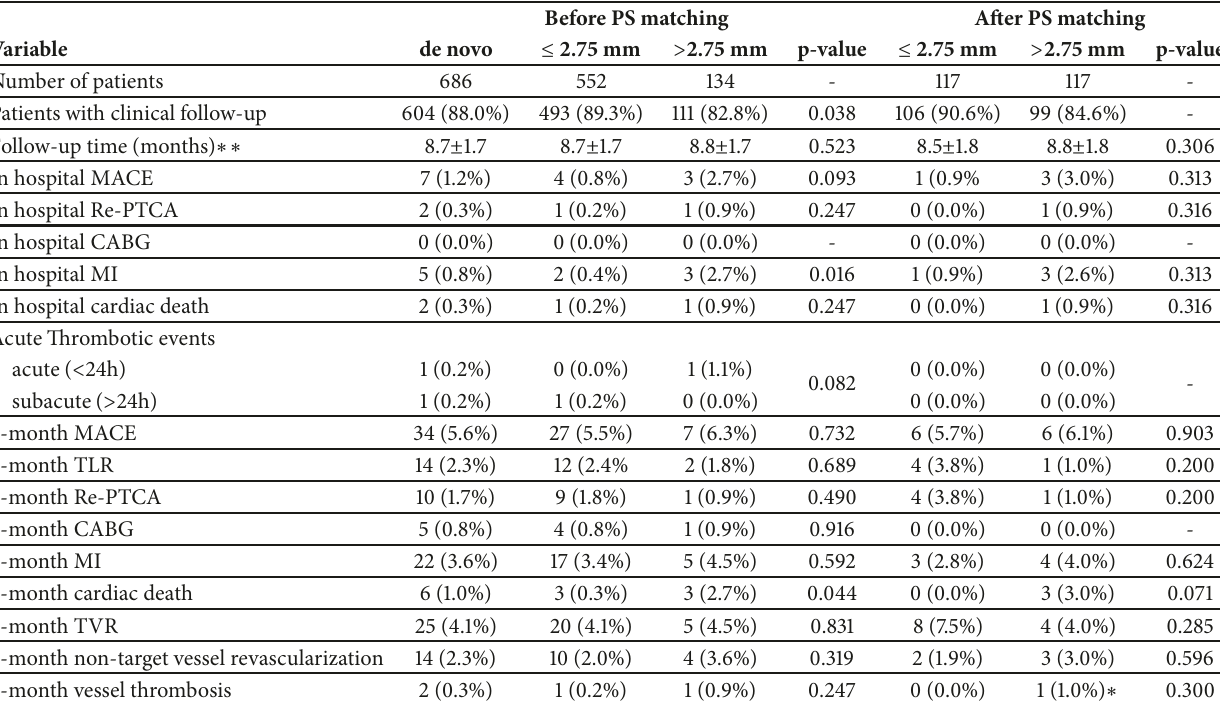
Table 3: Clinical outcomes.